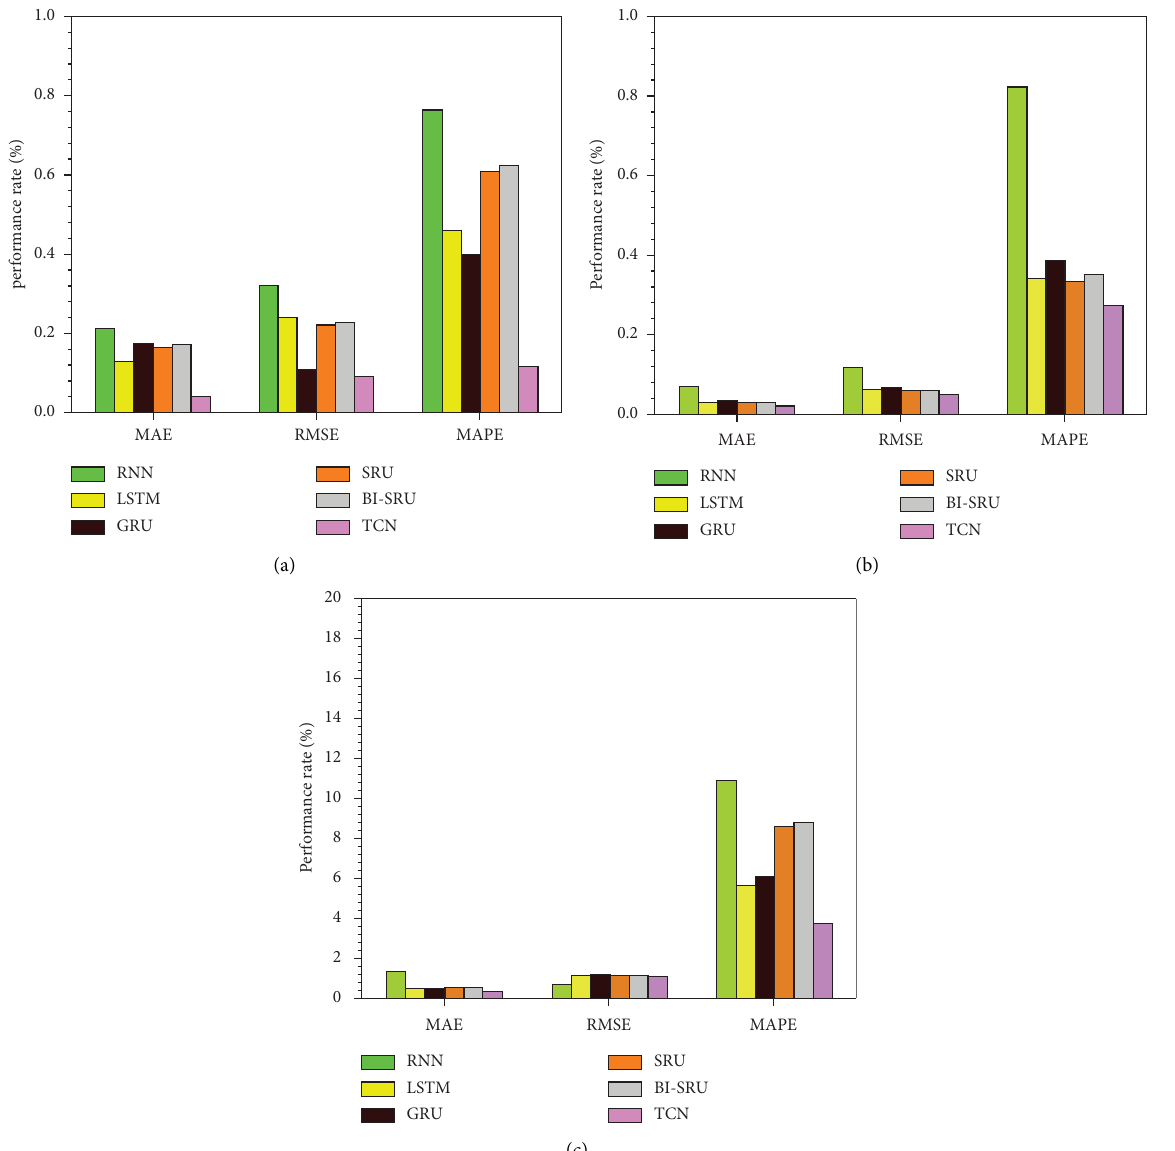
Figure 6: Performance rate for several models for (a) water temperature, (b) pH, and (c) dissolved oxygen as water